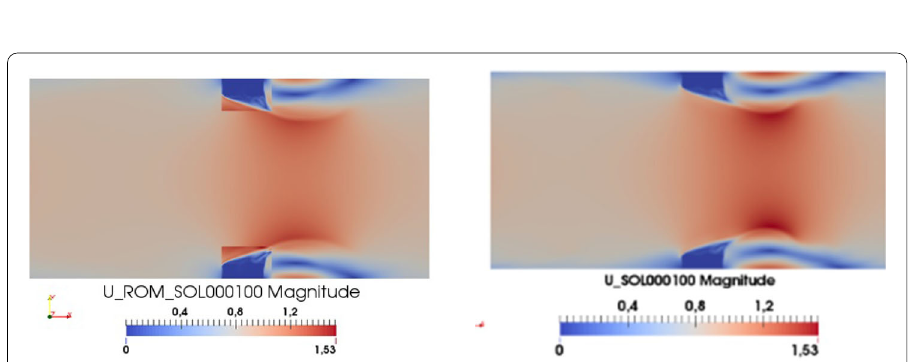
Fig. 7 On the left, the final time step corrected flow field U ROM ( t final ,G New ) by the UGPOD. On the right, U ( t final ,G New ) the final time step 2D laminar incompressible flow in a channel with the new configuration